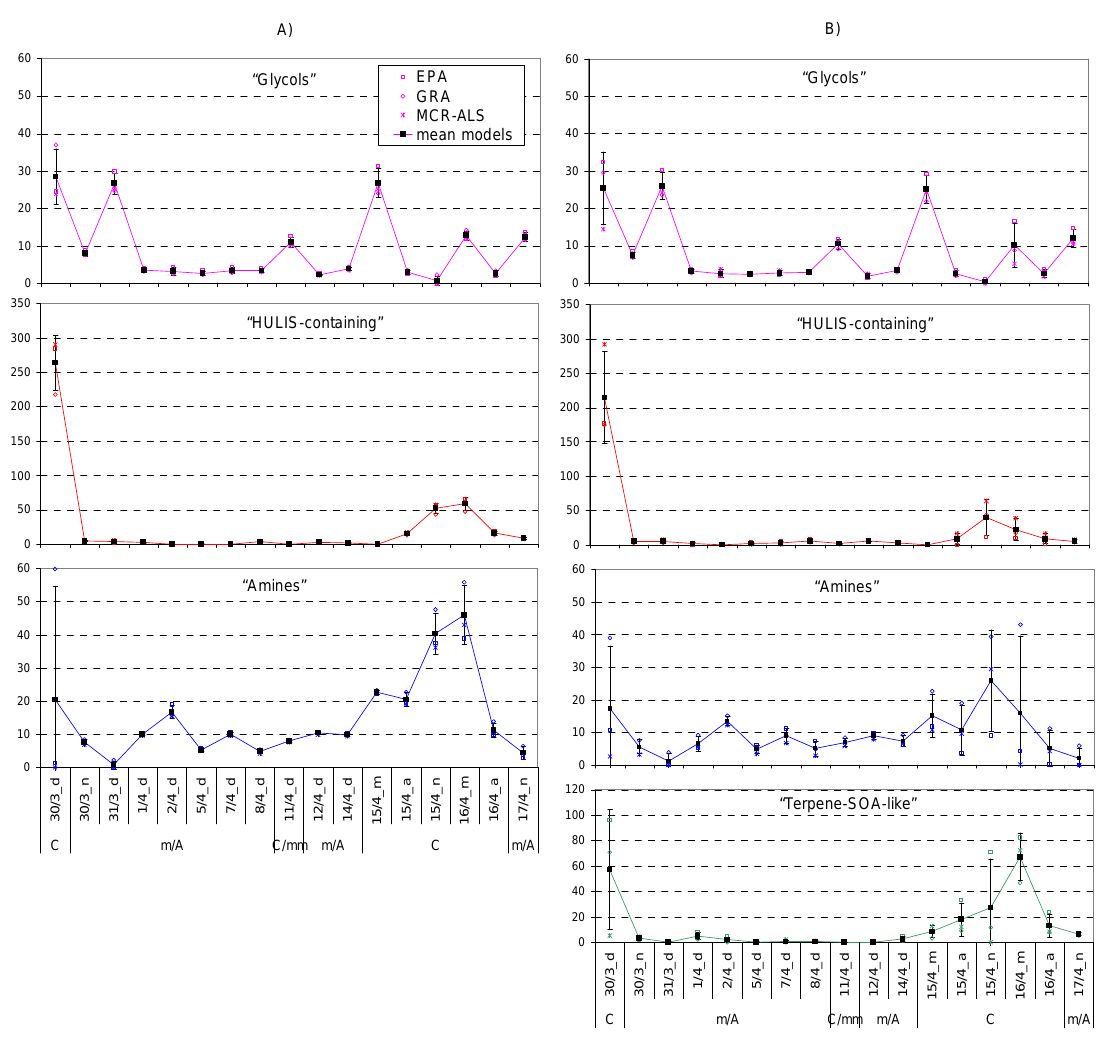
Fig. 9. NMR-factor loadings generated by the models applied to the low-resolution matrix with 3-factor solution (a) and 4-factor solution (b) . Within each factor, distinctive coloured symbols are used for different models while the black squared symbols represent mean values with vertical bar as standard deviations. Loadings are expressed as absolute values in nmolHm − 3